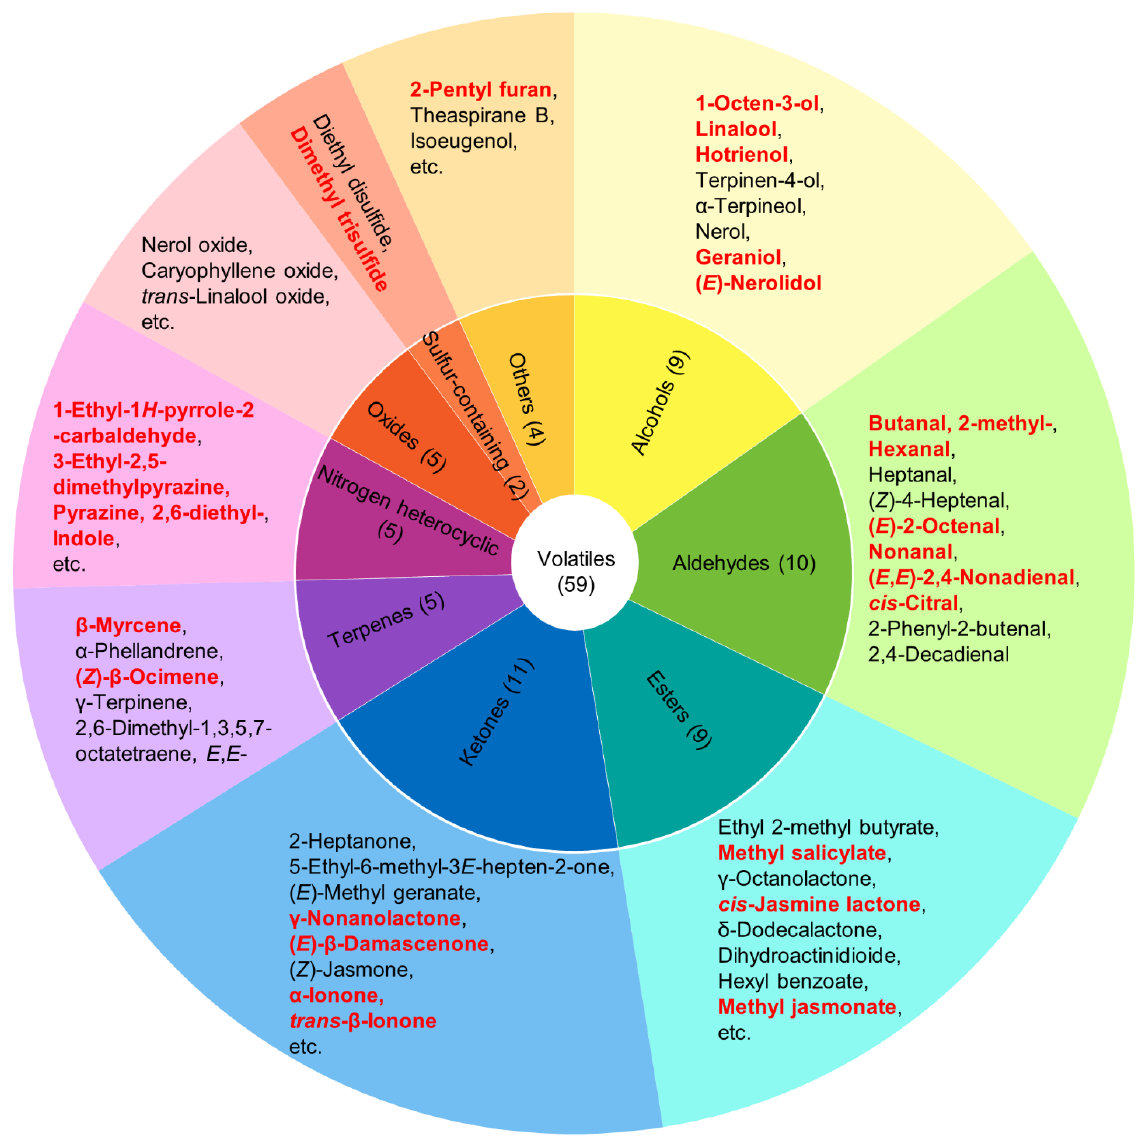
Figure 1. Categories of aroma compounds and specific compounds in Lingtou Dancong oolong tea product. The number in brackets indicates the number of compounds in each category. Compounds with an odor activity value (OAV) higher than 1 are highlighted in red.